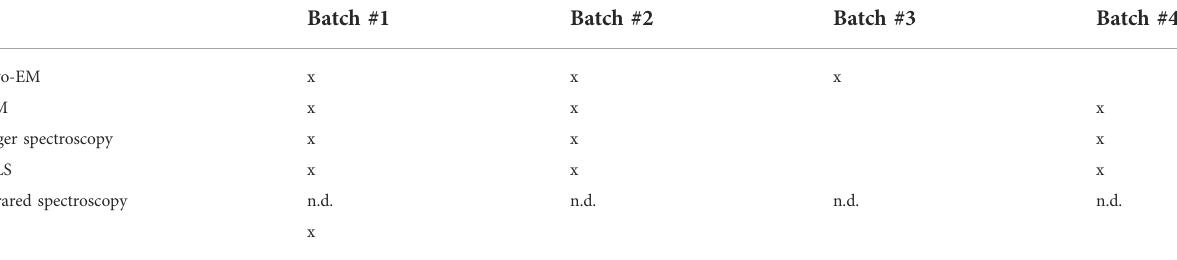
TABLE 1 Grid batch usage for each biophysical approach. Batches #1, #2, and #3 are copper Quantifoil R2/1 grids with a 2 nm extra continuous thin carbon layer. Batch #4 is copper Quantifoil R2/1 grids with 3 nm extra continuous thin carbon layer. Each batch was used (represented by an “ x ” sign) or not used (empty box) for some approaches mentioned in the fi rst column. The infrared spectroscopy analysis was not performed on grid batches (explained by the n.d. (not determined) abbreviation) as a Si prism was